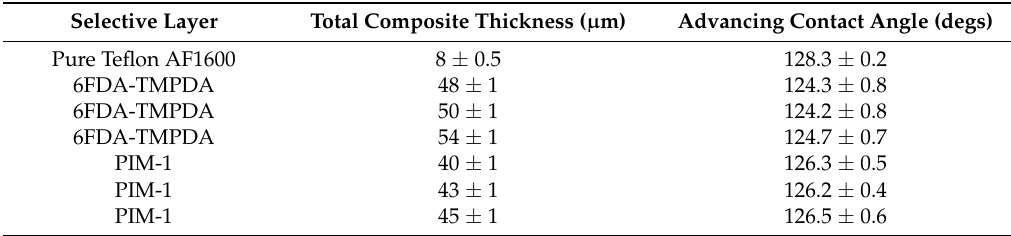
Table 2. Advancing water contact angle (degree) on the composite PIM-1 and 6FDA-TMPDA membranes with various thickness of the Teflon AF1600 protective layer, as well as that of pure Teflon